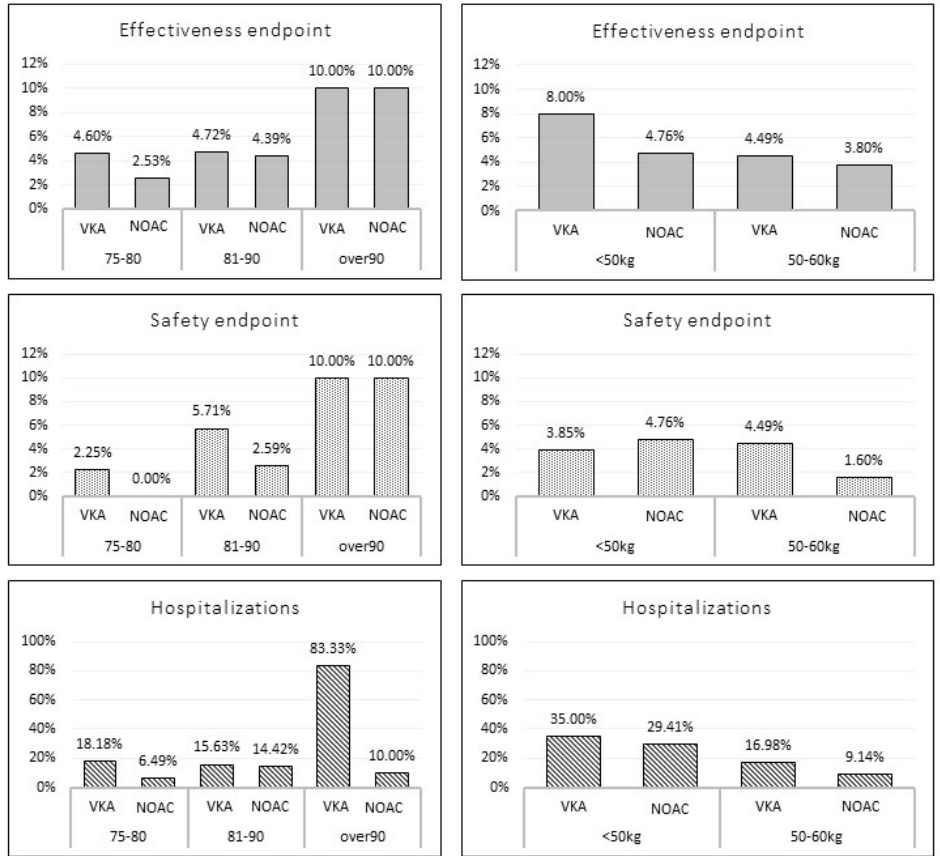
Figure 2. Incidence of the outcome events according to age and weight stratification among matched study population. VKA: vitamin K antagonist; NOAC; non-vitamin K oral anticoagulant. The Kaplan–Meier analysis showed no significant difference in 1 year survival from TE events (log rank: 0.08, p = 0.78), major bleeding (log rank: 1.05, p = 0.30) and all-cause death (log rank: 3.49, p = 0.06) in VKA versus NOAC group (Figures 3–5).